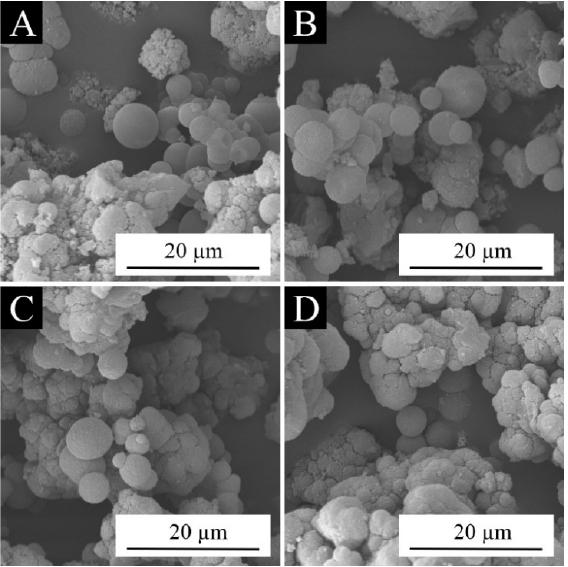
Figure 6. SEM images of microcapsules in the single factor experiment: ( A ) sample 10, ( B ) sample 13, ( C ) sample 15, and ( D ) sample 17.